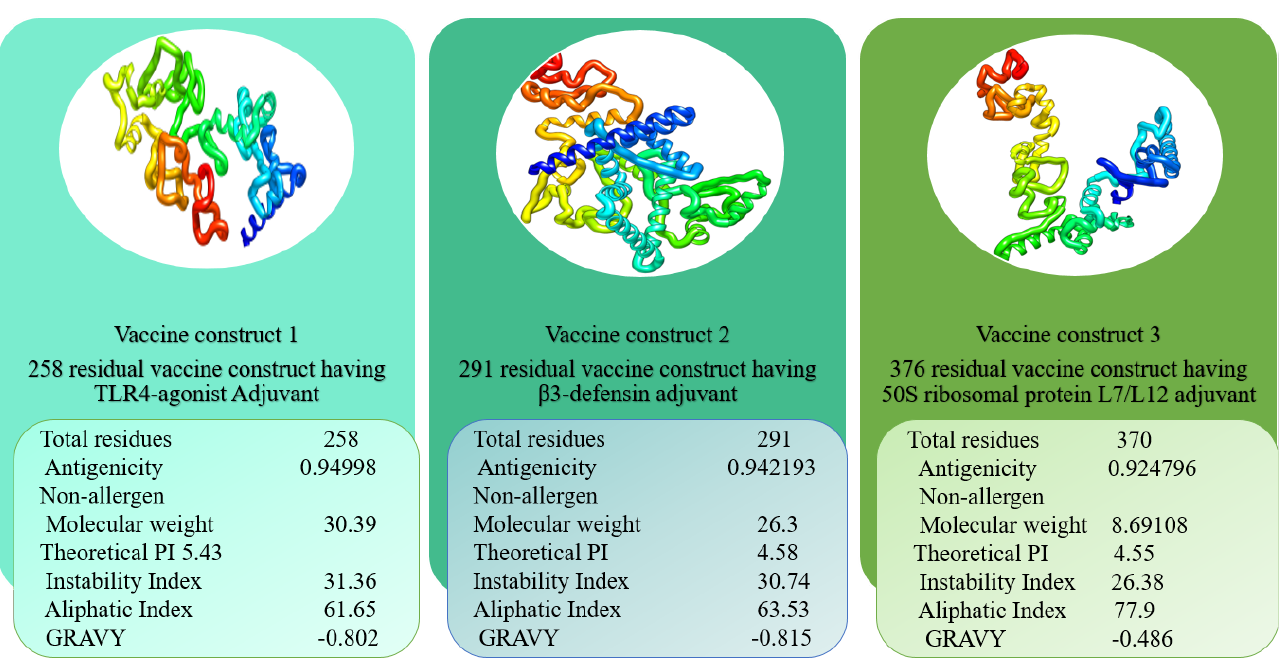
Figure 5. Structure characterisation of model vaccine with TLR4-agonist adjuvant ( A ) amino acid sequence, ( B ) 3D structure of 50S Ribosomal protein L7/L12 vaccine, ( C ) Ramachandran plot, ( D ) secondary structure elements, ( E ) original versus mutated structure, and ( F ) cloned vaccine into expression vector.